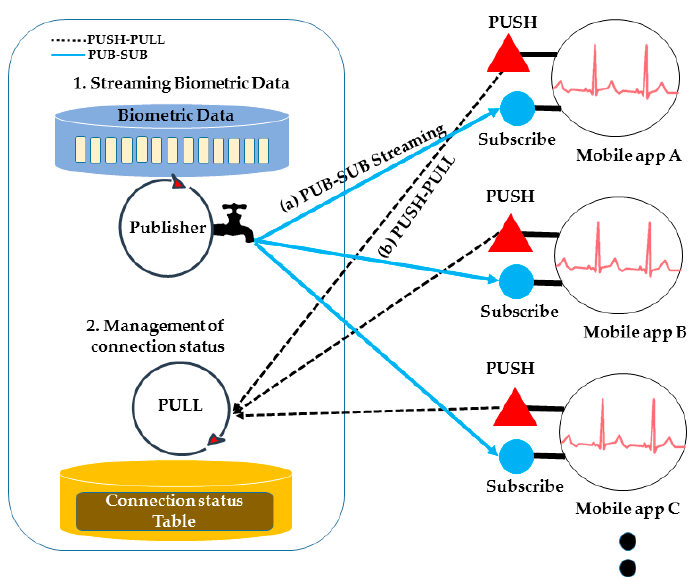
Figure 8. Bio-signal streaming and connection management.